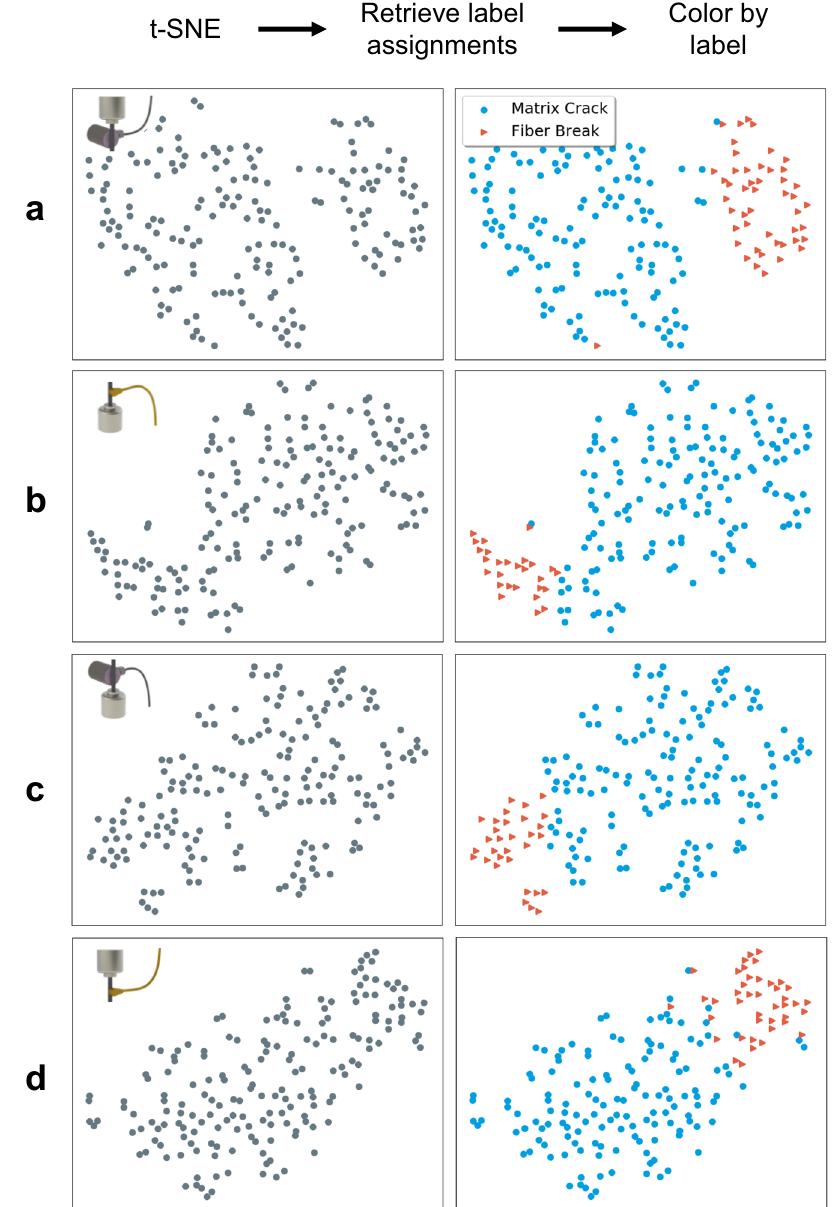
Fig. 5 Dimensionality reduction by t -SNE of Specimen 3 feature vectors. Plots for the raw feature vectors are shown for ( a ) B1025-a, ( b ) S9225-b, ( c ) B1025-b, and ( d ) S9225-a on the left and are subsequently colored on the right according to the labels given after spectral clustering as described in Fig. 3. While the t -SNE axes have no intrinsic meaning, well-formed clusters indicate that partitions were made according to similarity between feature vectors and are not an artifact of the clustering